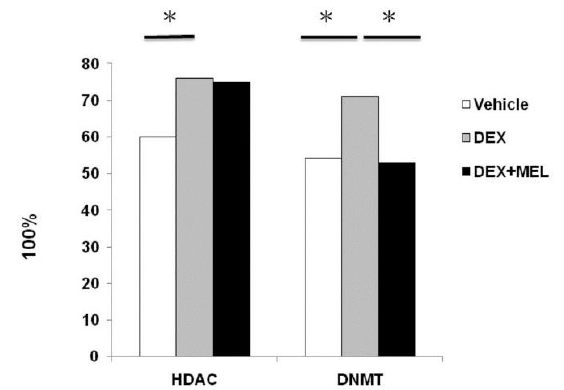
Figure 4. Histone deacetylation (HDAC) and DNA methyltransferase (DNMT) activity in the liver. The histone modifications in fatty liver were studied via HDAC activity and leptin DNMT activity.